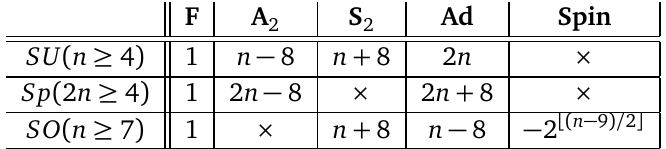
) d abcd ( R ) for SU ( 2,3,4,5,6 ) respectively, 1 2 ( F ) = 1 / 2 multiply each 2